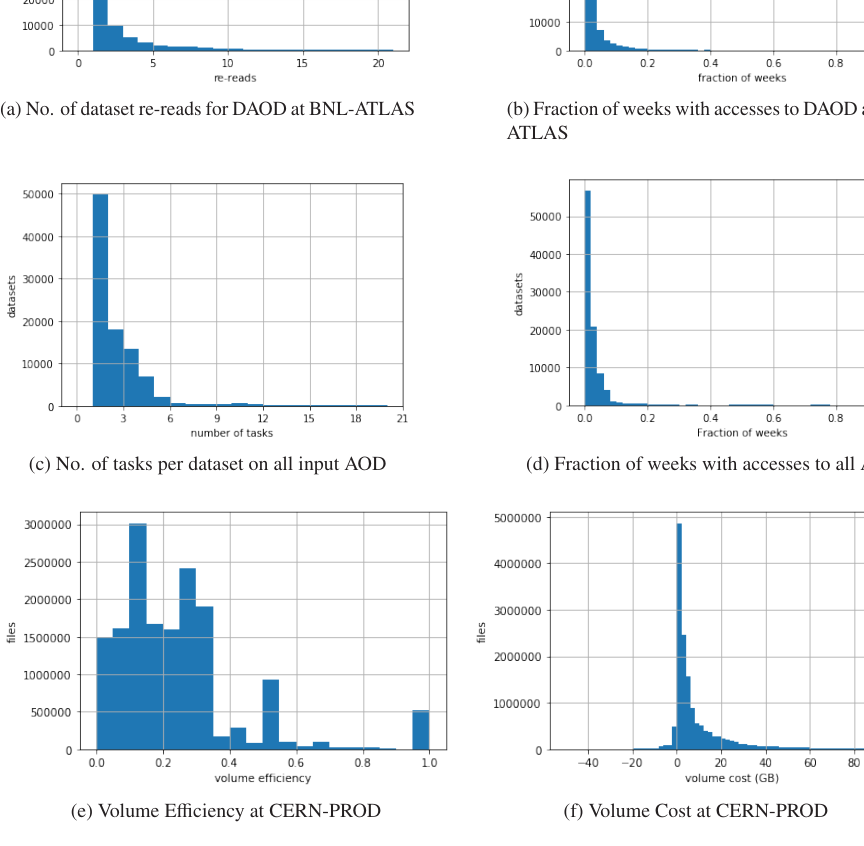
Figure 5: Dataset access patterns in 2020